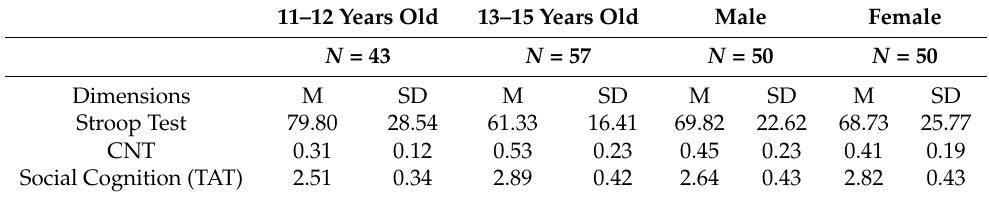
Table 1. Descriptive Statistics for Executive function and Social cognition dimensions.